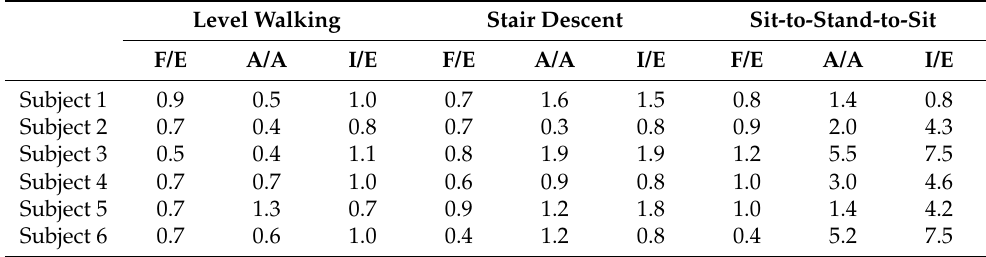
Table A1. Root-mean-square error (in degrees) between sensor-estimated kinematics and simulator- generated ground truth data, throughout a representative activity cycle. Results are shown for all six subjects, for every activity type, in each of the three rotation planes. (F/E = flexion/extension; A/A = adduction/abduction; I/E = internal/external tibial